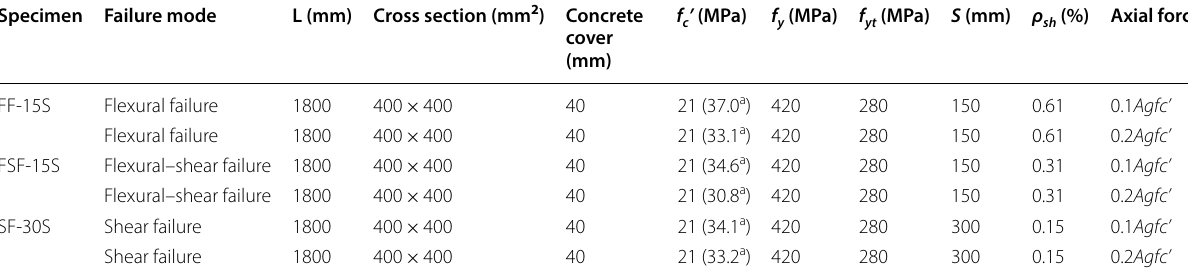
Table 5 Detailed information of each